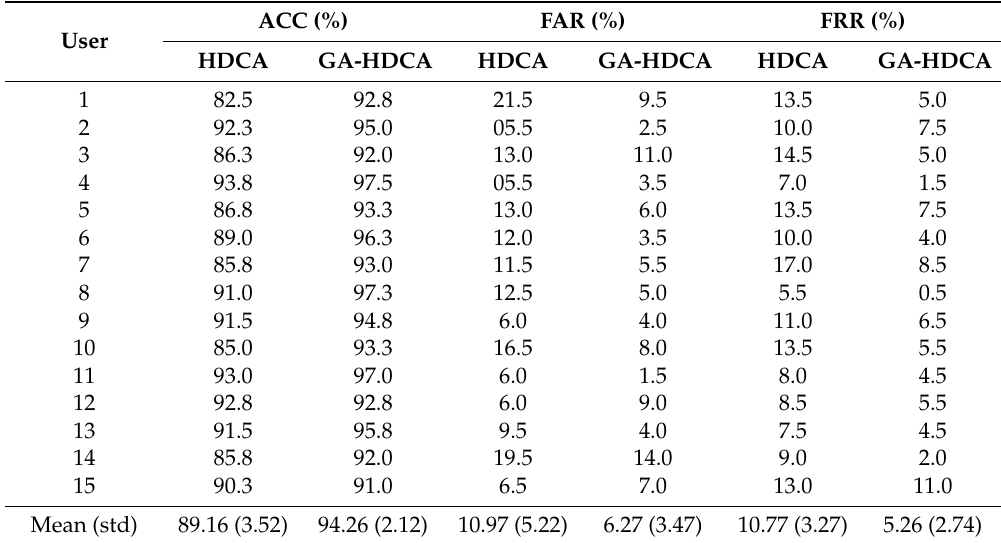
Table 1. Authentication performances with HDCA and